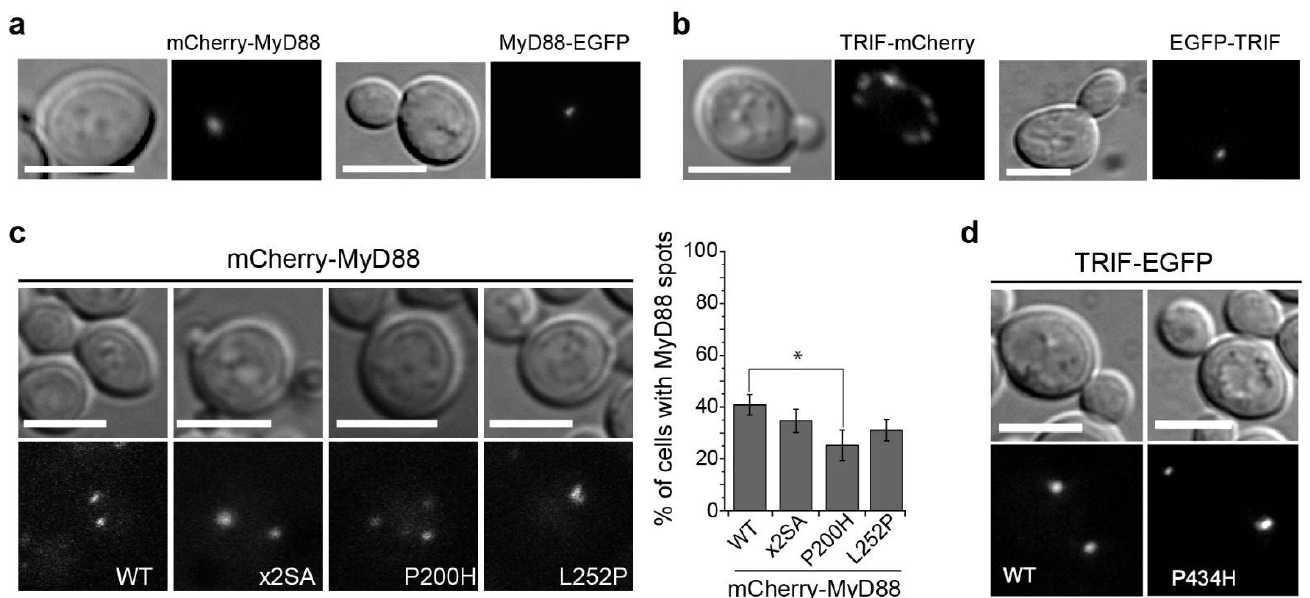
Figure 5. Point mutants in the TIR domain of MyD88 and TRIF do not alter their cytoplasmic spot localization. ( a ) Differential interference contrast and fluorescence microscopy of YPH499 yeast cells expressing either mCherry-MyD88 or MyD88-EGFP from plasmid pYES3 and pAG425GAL, respectively. ( b ) TRIF-mCherry or EGFP-TRIF from plasmids pYES3 and pAG425GAL, respectively. ( c ) Differential interference contrast and fluorescence microscopy of YPH499 yeast cells bearing mCherry-MyD88 WT and the indicated mutants, from pYES3 derivative plasmids (left) and a graph displaying the percentage of yeast cells showing MyD88 spots (right). Data correspond to means ± standard deviation of three independent transformants ( n > 100). Normality was checked by the Shapiro–Wilk test. One ‐ way ANOVA statistical comparison retrieved a p ‐ value = 0.021 (*) for WT vs. P200H mutant. ( d ) Differential interference contrast and fluorescence microscopy of YPH499 yeast cells bearing EGFP ‐ TRIF WT and the P434H mutant from pAG425GAL ‐ EGFP derivative plasmids. Scale bars correspond to 5 μ m.